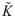
Correspondence between the radius at which K˜ is maximized and the radius of aggregates at binary and non-binary fields of view.Each K˜ result displayed represents the average of 30 simulated fields of view using the exact same experimental parameters. Panel A: Simulations were applied at very low event densities (0.01 particles per pixel) with and without a diffuse pool. Left—Sample simulated fields of view. The image intensities have been rescaled for display purposes. Right—Corresponding K˜ profile. Panel B: Simulations were applied at high event densities (10 particles per pixel) with and without a diffuse pool. For simulations where a diffuse pool is present, the Aggregate-to-Diffuse ratio (ADR) and Signal-to-Background ratio (SBR) were set at 0.05 and 3, respectively. Left—Sample simulated fields of view. Right—Corresponding K˜ profile.